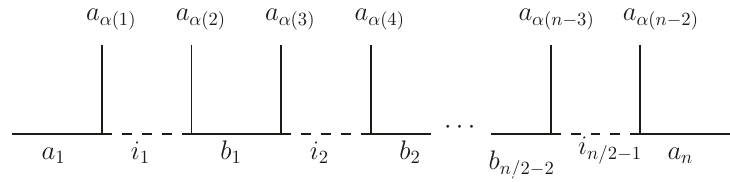
and f ijk as vertices. ab